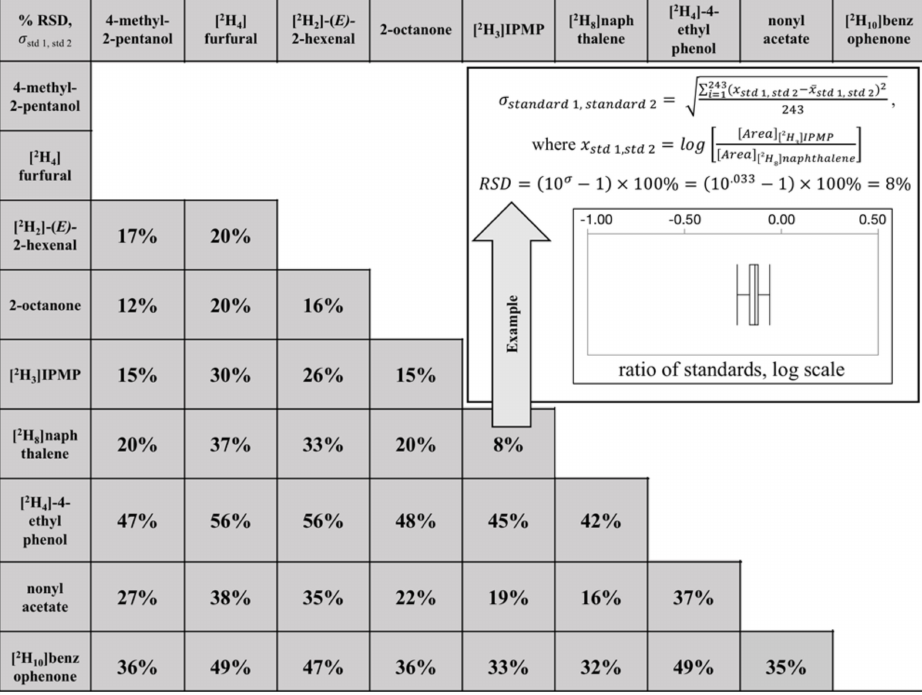
Figure 4. Compound × Individual matrix effects (%RSD) for pairs of nine non-native internal standards in a tomato